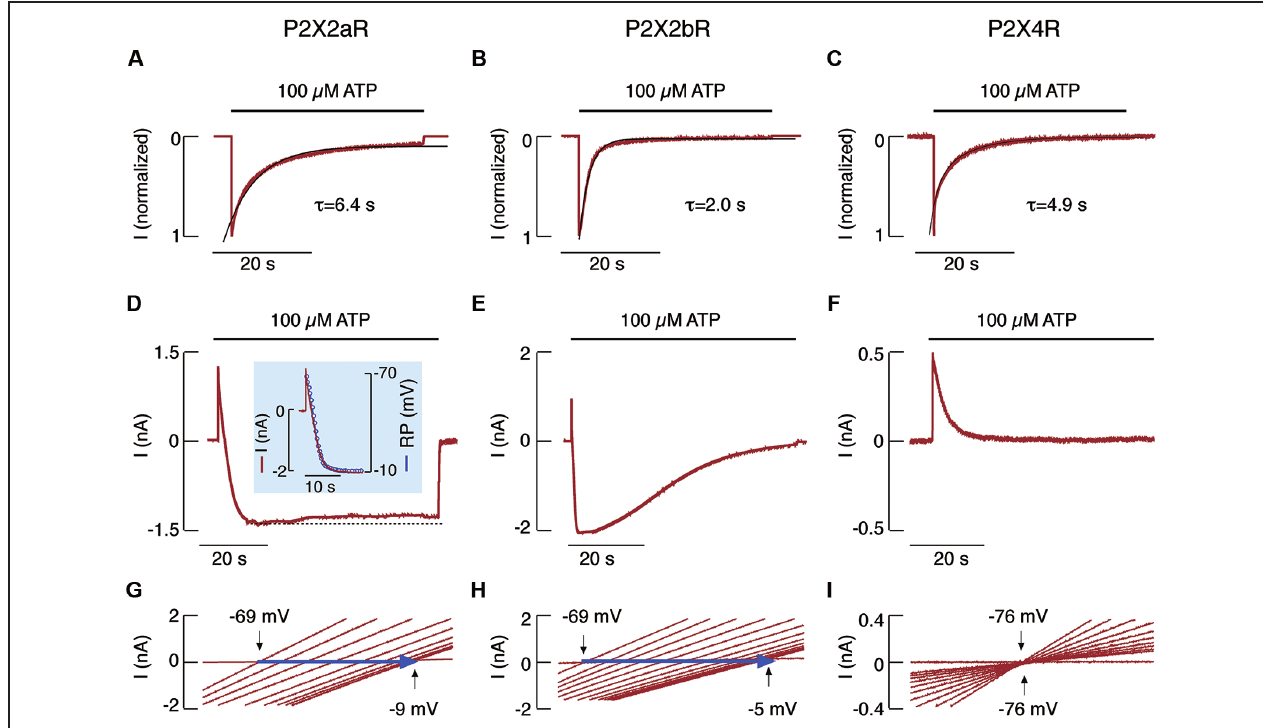
FIGURE 2 | NMDG + permeability of rP2X2aR, rP2X2bR and rP2X4R expressed in HEK293 cells . (A–C) Patterns of ATP-induced currents in cells bathed in a normal physiological medium. Traces shown were obtained during the first (P2X4R) and third (P2X2aR and P2X2bR) ATP application. Black lines indicate exponential fittings, with τ des shown below the traces. (D–I) . Patterns of ATP-induced current (D–F)